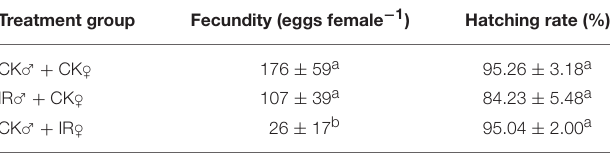
TABLE 2 | Effects of 400Gy irradiation of adults on fecundity and egg hatch